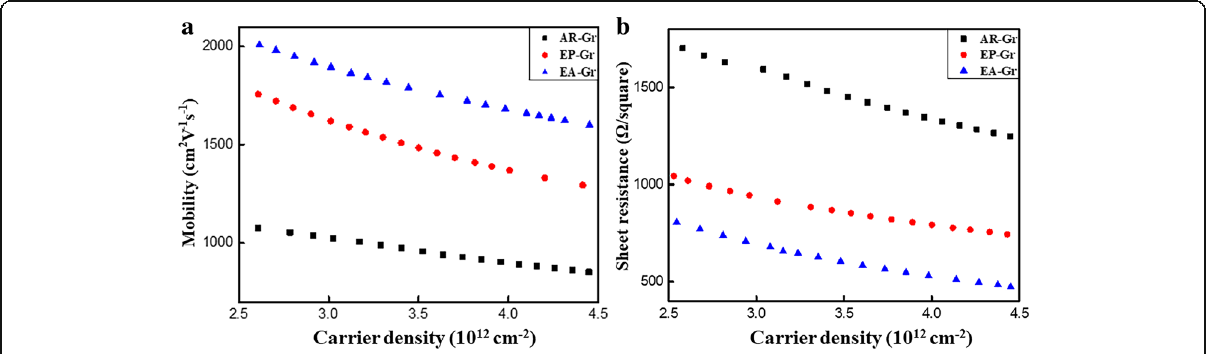
Fig. 5 Plot of graphene a carrier mobility vs carrier density and b sheet resistance vs carrier density at room